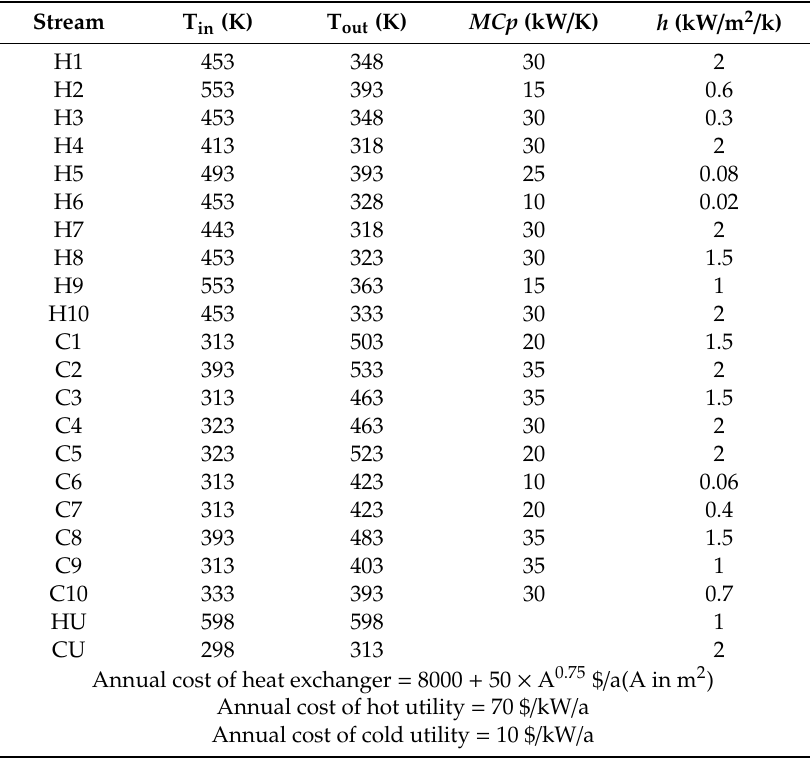
Table 7. Stream, cost, and parameters of case